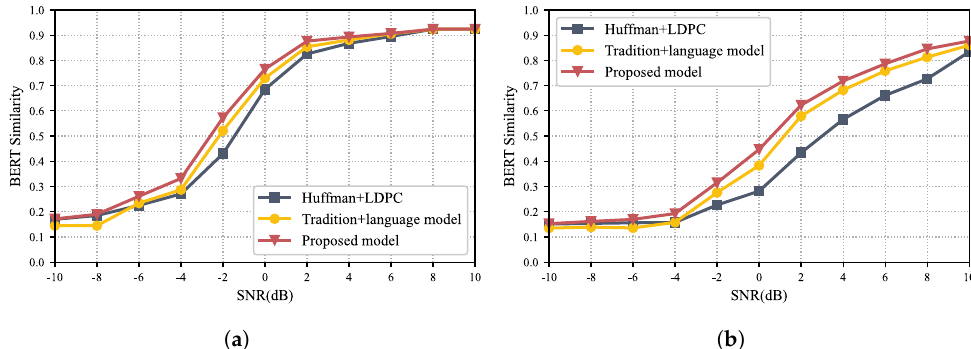
Figure 5. ( a ) Similarity score based on BERT versus SNR over the AWGN channel. ( b ) Similarity score based on BERT versus SNR over the Rayleigh fading channel.